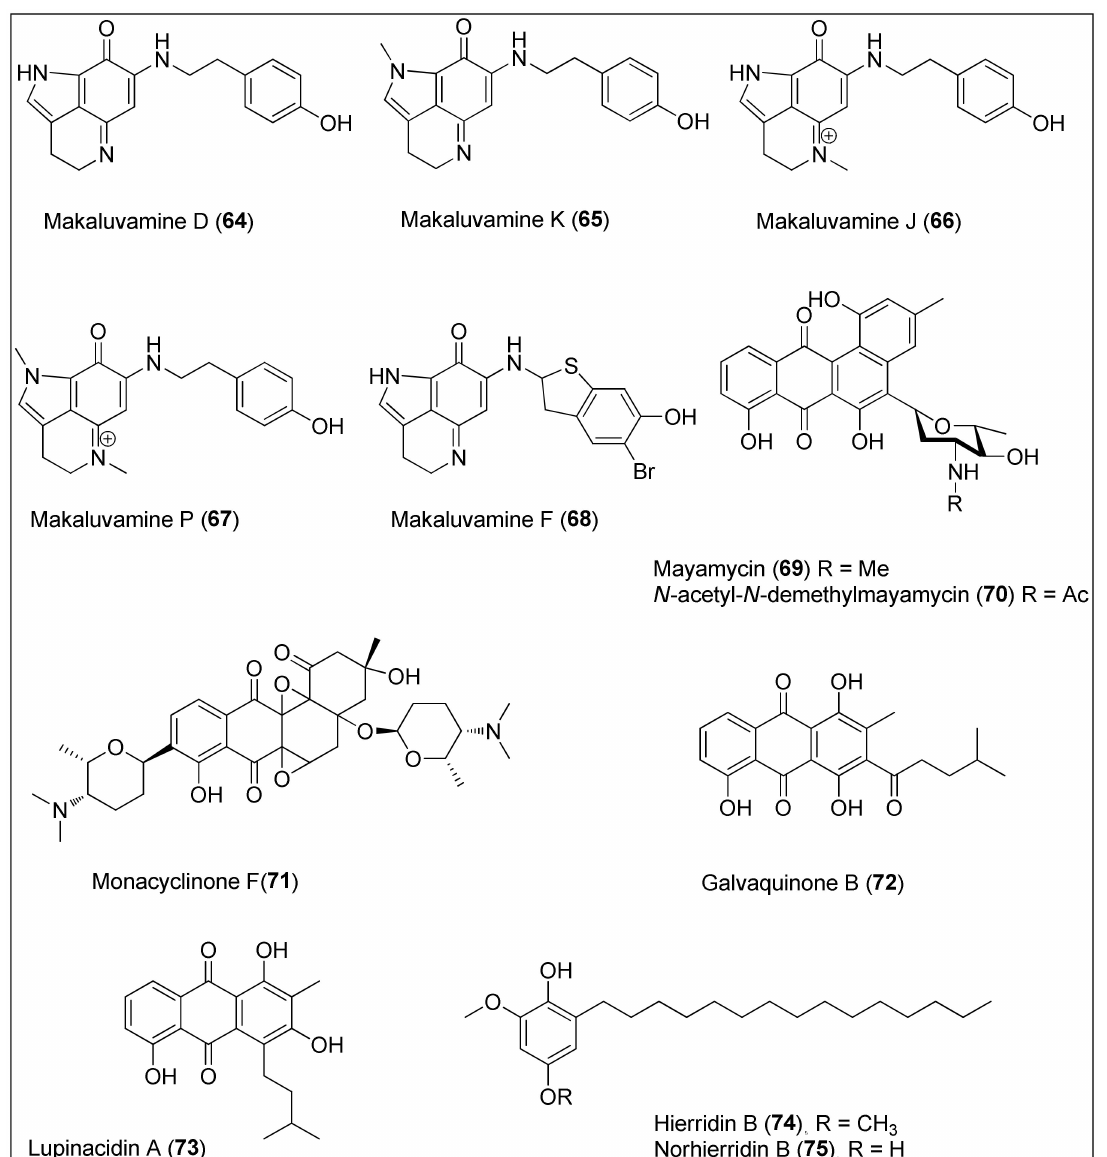
Figure 7. Makaluvamines D ( 64 ), K ( 65 ), J ( 66 ), P ( 67 ) and F ( 68 ) isolated from the two sponge genera of Zyzzya and Latrunculi, mayamycin ( 69 ) and N-acetyl-N-demethylmayamycin ( 70 ) isolated from the Streptomyces sp. strains HB202 and 182SMLY, respectively; monacyclinone F ( 71 ) isolated from the Streptomyces sp. strain M7_15, galvaquinone B ( 72 ) and lupinacidin A ( 73 ) isolated from the Streptomyces spinoverrucosus and hierridin B ( 74 ) isolated from the Phormidium ectocarpi and Cyanobium sp. and its structural analogue, norhierrdin B ( 75